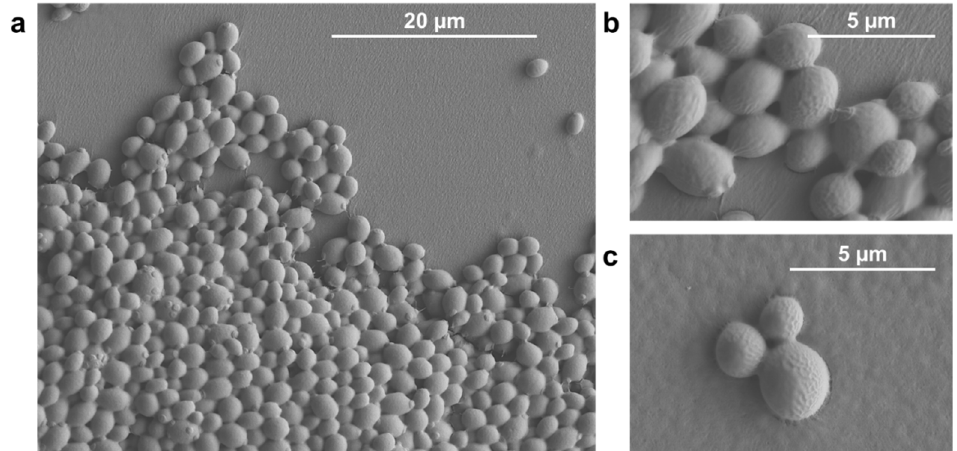
Figure 7. Cryo-scanning electron micrographs of Candida glabrata in the ( a , b ) absence ( c ) and presence of isovaleric acid.